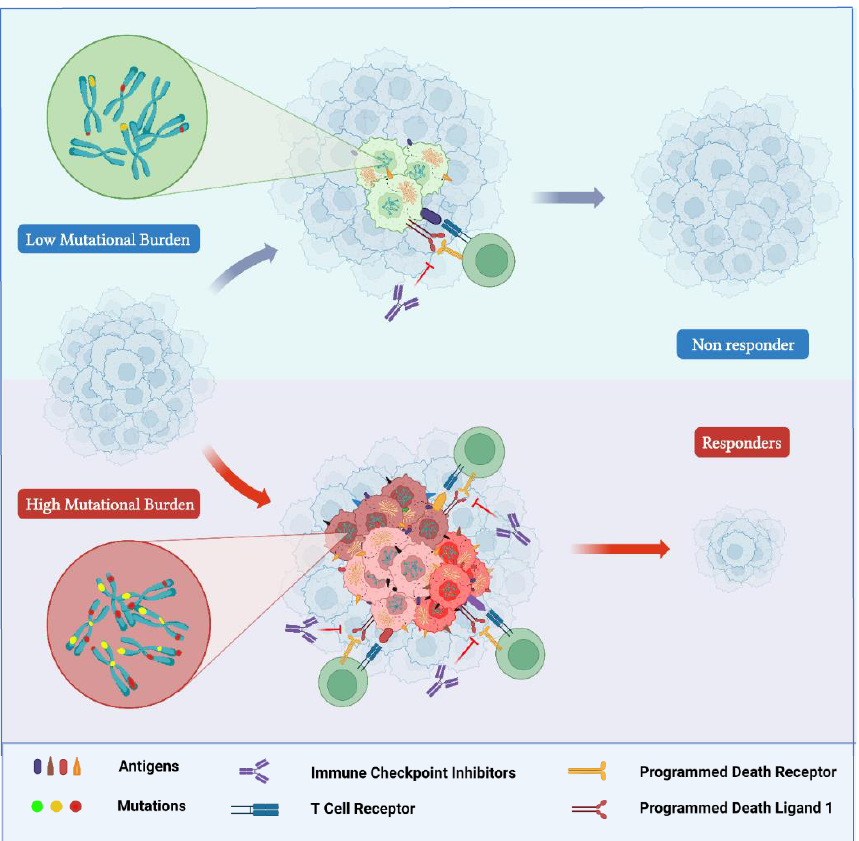
Figure 2. TMB-H tumors are characterized by higher levels of production of tumor-specific mutant epitopes that may function as neoantigens identified as “non-self” by the immune system. Hyper-mutated tumors ( bottom ) are more responsive than hypo-mutated tumors ( top ) to immune checkpoint inhibitors. “Created with BioRender.com”.